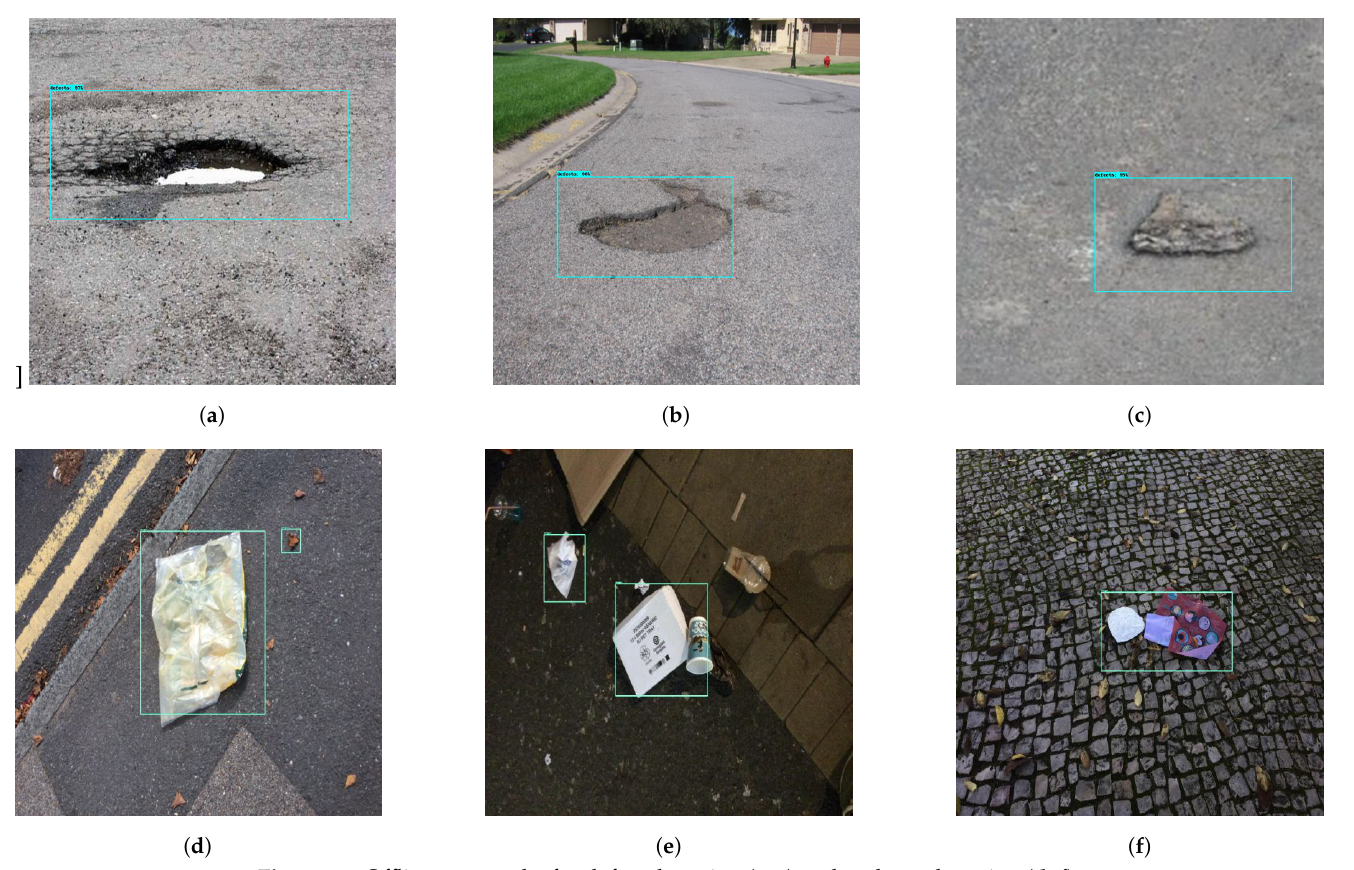
Figure 10. Offline test results for defect detection ( a – c ) and garbage detection ( d – f ).